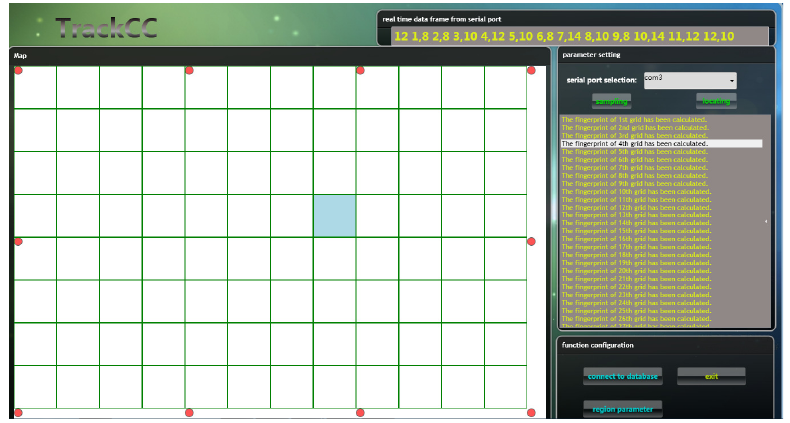
Figure 4. The software of the TrackCC running on the